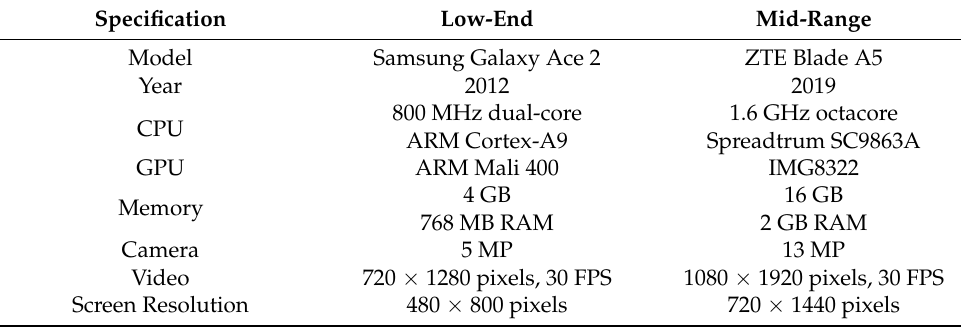
Table 2. Dimensions and resolution of the pattern images as well as size and number of faces and vertices of the 3D models used in the